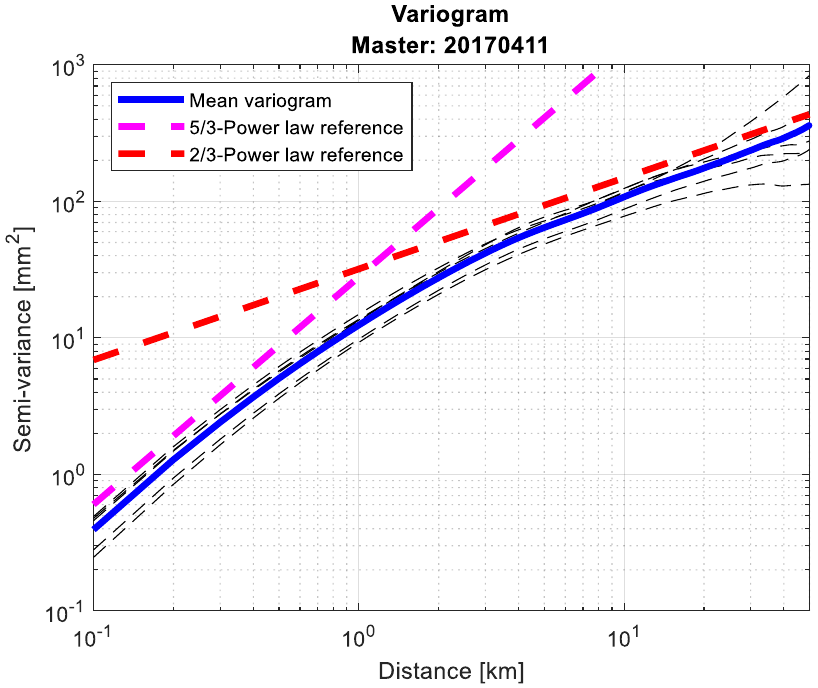
Figure 13. (black dashed lines) spatial variograms for all the APS maps derived using the dataset in Table 3. (Blue line) mean of all the previous variograms. (Red dashed line) reference power law with ρ = 2/3 and C selected as a best fitting value. (Pink dashed line) reference power law with ρ = 5/3. A good fitting is shown in the average of all the variograms derived for every single data.